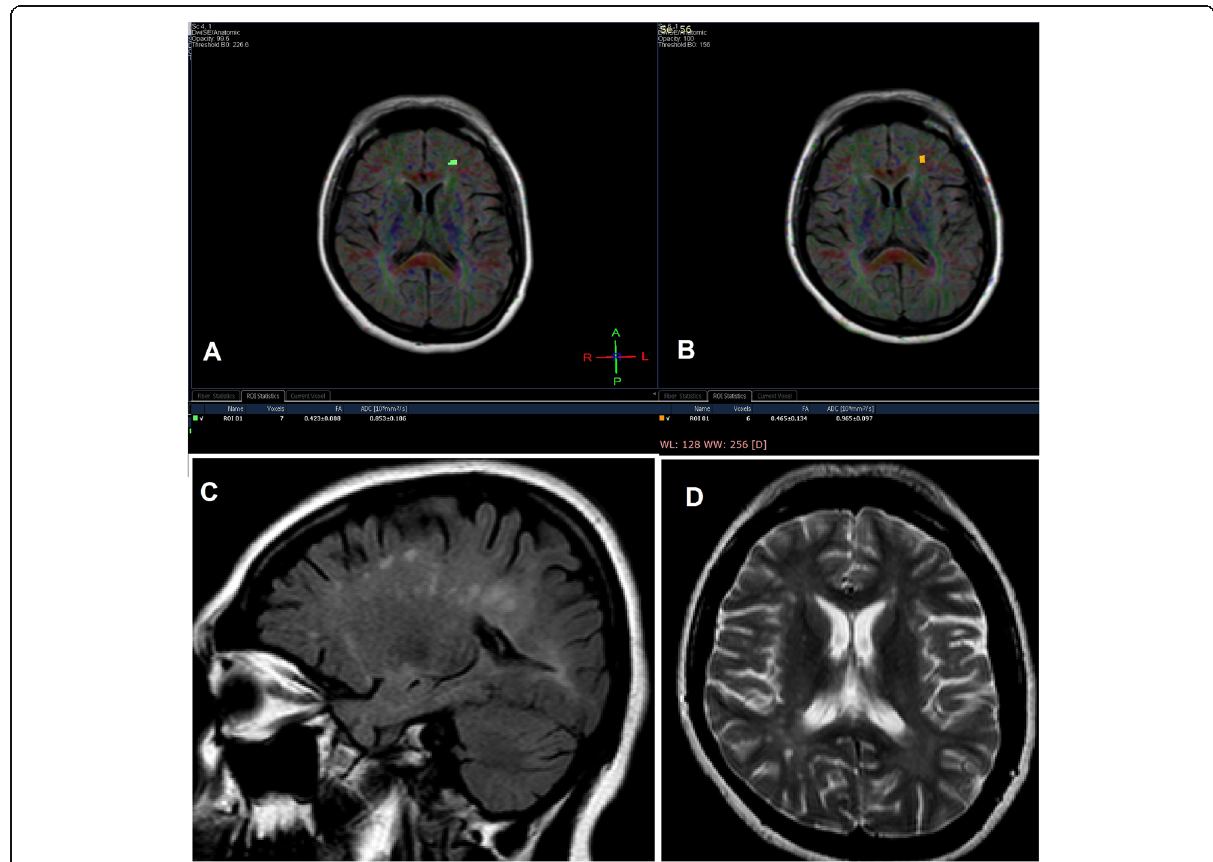
Fig. 2 A 30-year-old female patient (BDI score 13). a Colour-coded FA maps overlaid on axial FLAIR showing FA measurement in the left dorsolateral prefrontal white matter (0.423 ± 0.088). b The MRI examination 6 weeks following rTMS therapy showing an increase in FA value (0.465 ± 0.134). c Sagittal FLAIR and d axial T2 weighted images showing the bilateral cerebral white matter demyelinating plaques